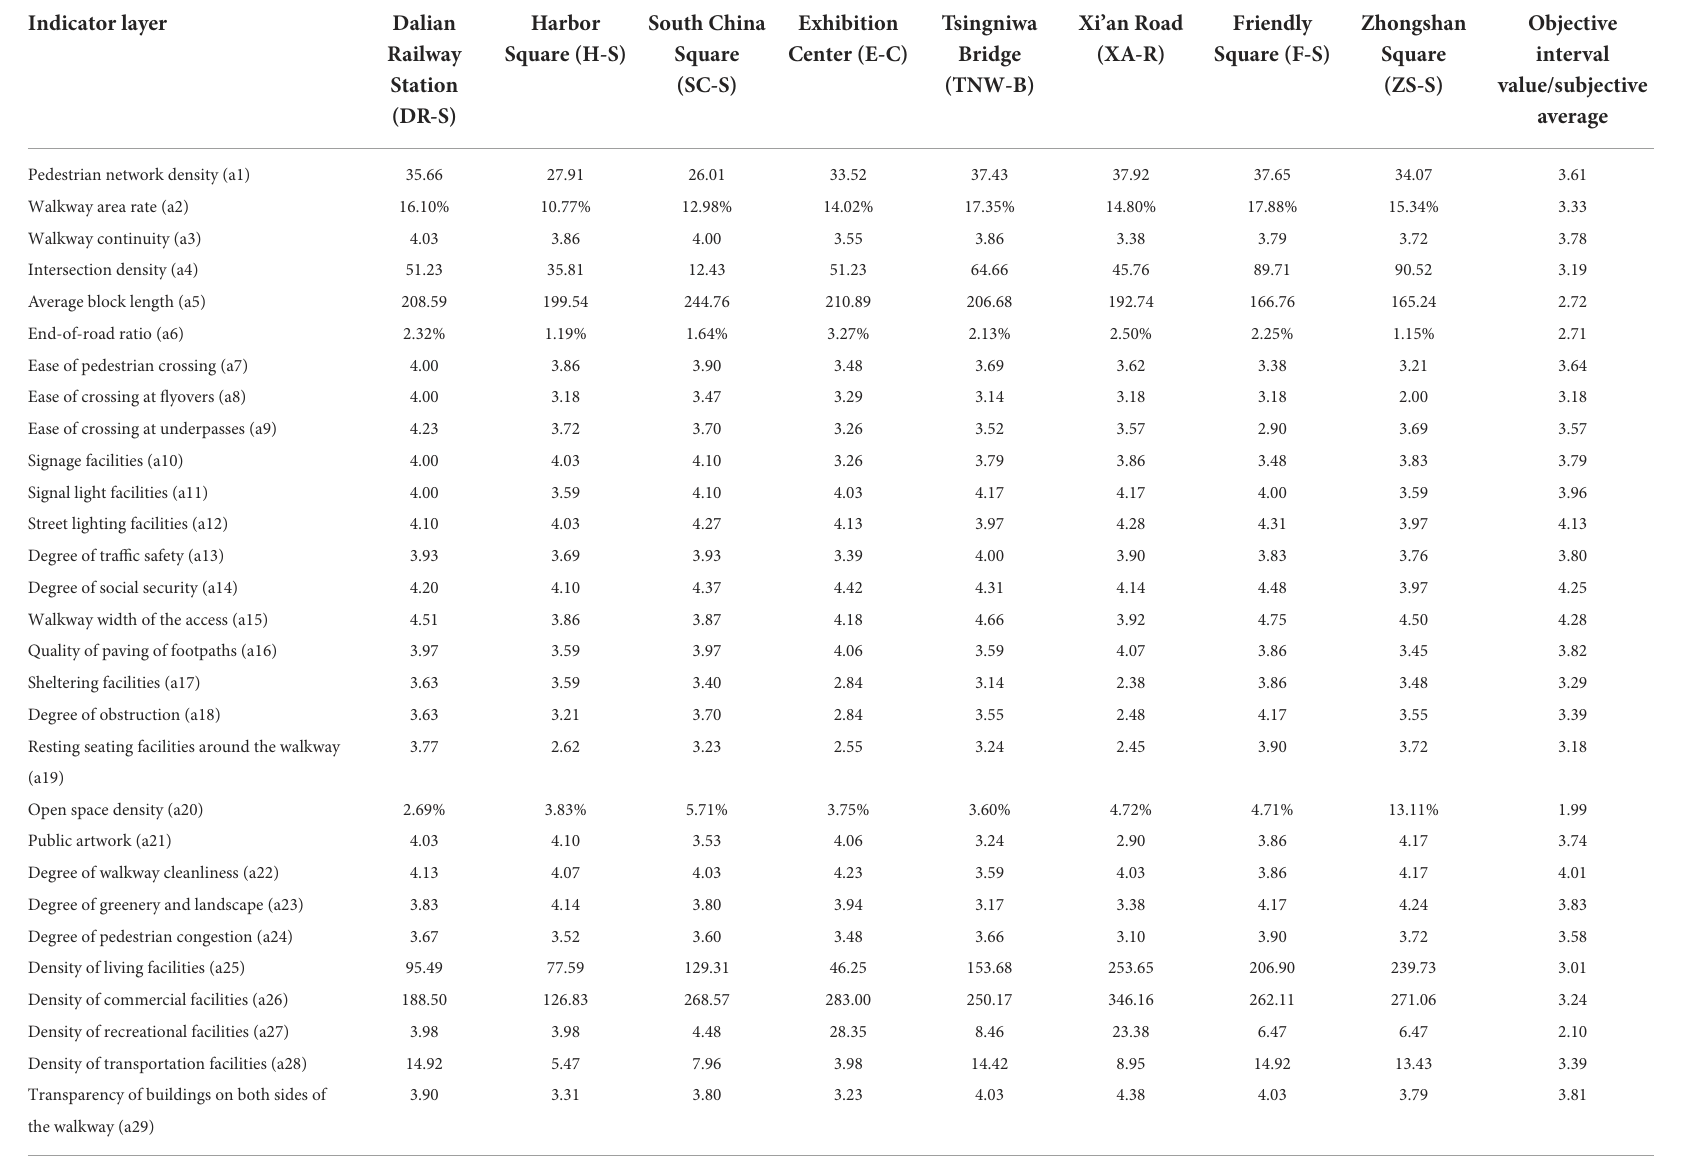
TABLE 4 Evaluation indicator scores for each station area. Indicator